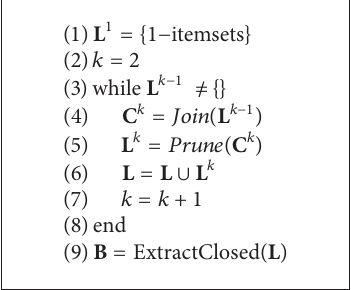
Pseudocode 1: Pseudocode of the Apriori-like algorithm.